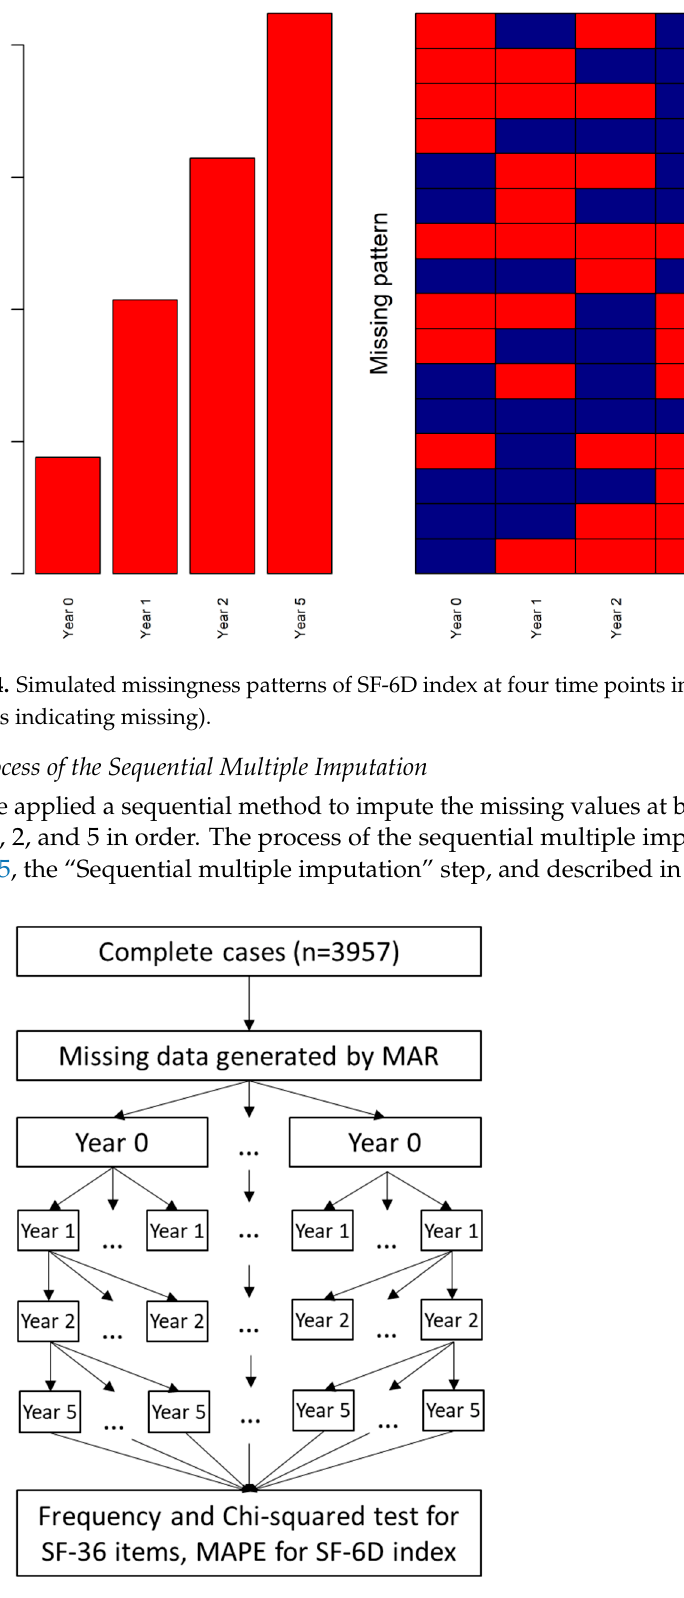
Figure 3. Missing proportions ( left ) and missingness patterns ( right ) of the SF-6D index at four time points in the real-world data (red cells indicating missing).